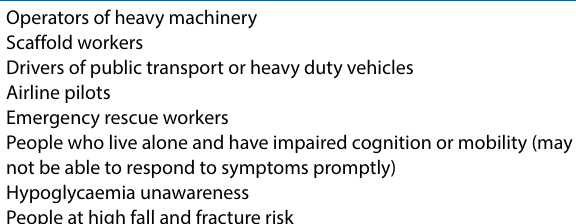
Figure III: Circumstances where the consequences of hypoglycaemia may be catastrophic Operators of heavy machinery Scaffold workers Drivers of public transport or heavy duty vehicles Airline